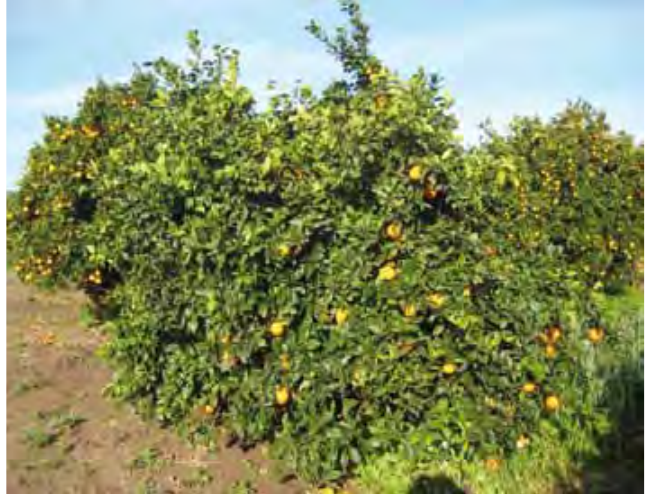
Fig. 3 - ‘Navelina’ orange tree.